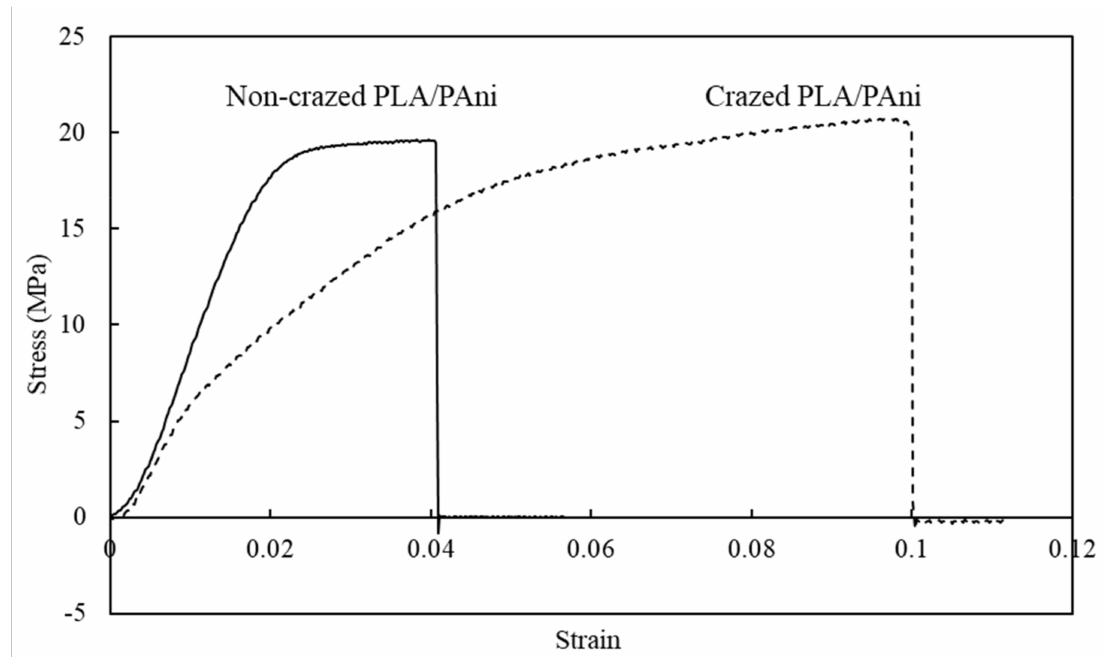
Figure 5. Stress–strain curve graph of non-crazed PLA/PAni film and crazed PLA/PAni